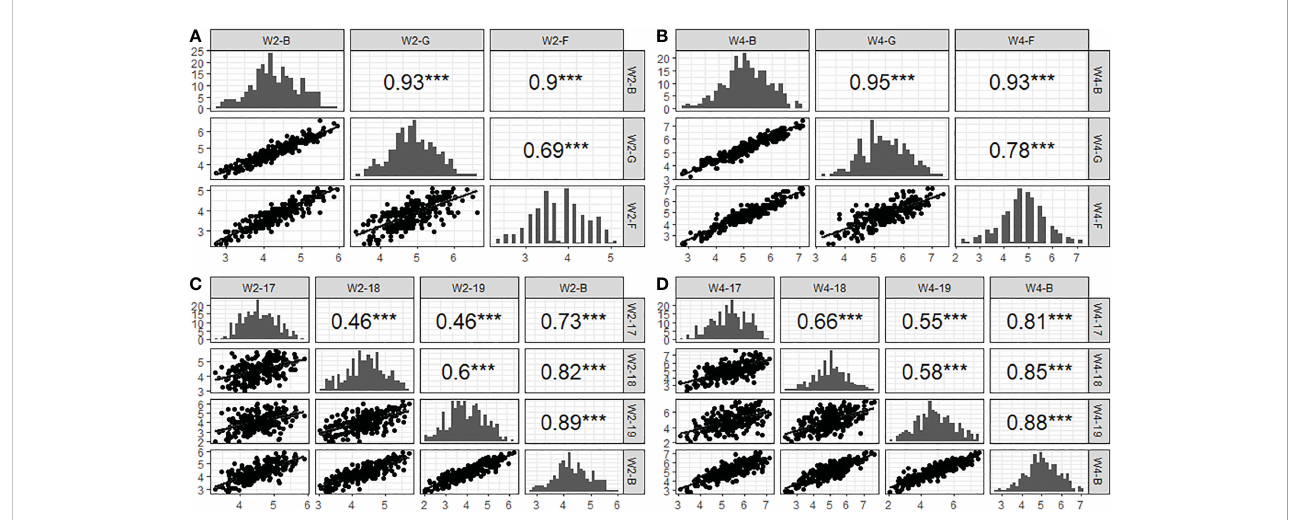
FIGURE 4 Correlation and distribution of SES from 2017 to 2019 acorss three conditions (greenhouse, fi eld and BLUP). (A) : W2-B, W2-G and W2-F represent two week ’ s SES of BLUP, greenhouse and fi eld, respectively. (B) : W4-B, W4-G and W4-F representfour week ’ s SES of BLUP, greenhouse and fi eld, respectively. (C) : W2-17, W2-18 and W2-19 represent two week ’ s SES of 2017, 2018 and 2019, respectively. (D) : W4-17, W4-18 and W4-19 represent four week ’ s SES of 2017, 2018 and 2019, respectively. *** indicated the level of signi fi cance reached 0.001.